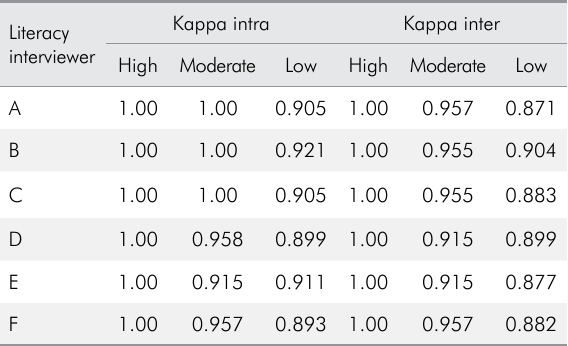
Table 1. Intra- and inter-rater kappa coefficient based on each word of the BREALD-30 according to the different levels of oral health literacy.